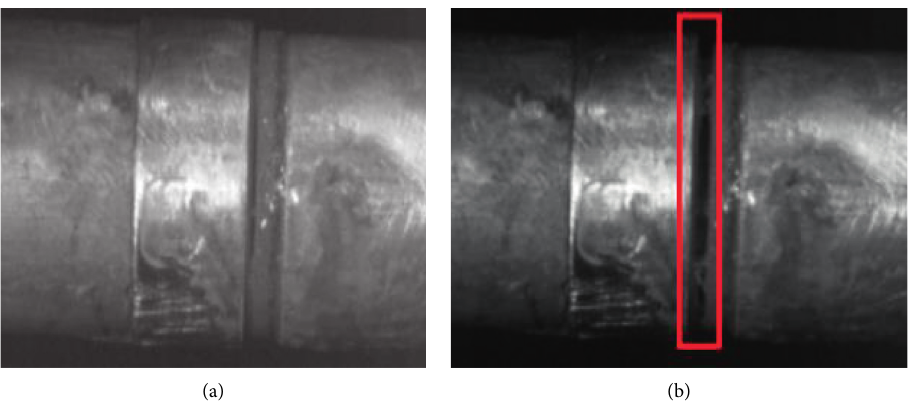
Figure 5: Comparison of the stretching of the bonding specimen by using 502 super glue. (a) Before stretching. (b) The moment when wave transmits to the specimen.